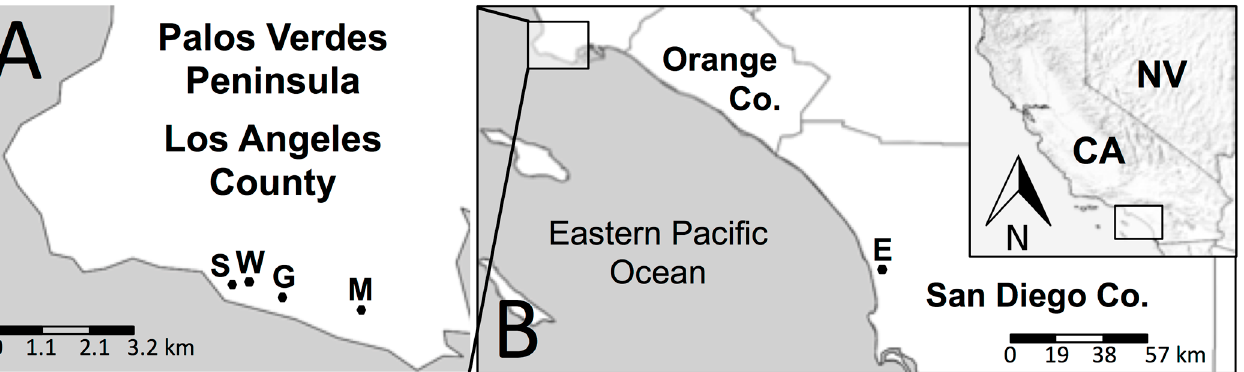
Figure 1. The collection sites for Theba pisana (Müller, 1774) in Los Angeles and San Diego Counties, California, USA. ( A ) map of the Palos Verdes Peninsula, Los Angeles Co., S: south entrance of White Point Nature Preserve (WPNP), San Pedro; W: native plant garden, WPNP, San Pedro; G: grassland loop trail of WPNP, San Pedro; M: Marine Mammal Care Center, San Pedro; ( B ) map of southwestern Los Angeles Co. to San Diego Co., California (CA), NV: Nevada, USA; E: Santa Carina trail at San Elijo Lagoon Ecological Reserve, San Diego County. Table 1. Data for Theba pisana (Müller, 1774) specimens collected from Los Angeles and San Diego counties, California, USA and used in this study. LACM Lot